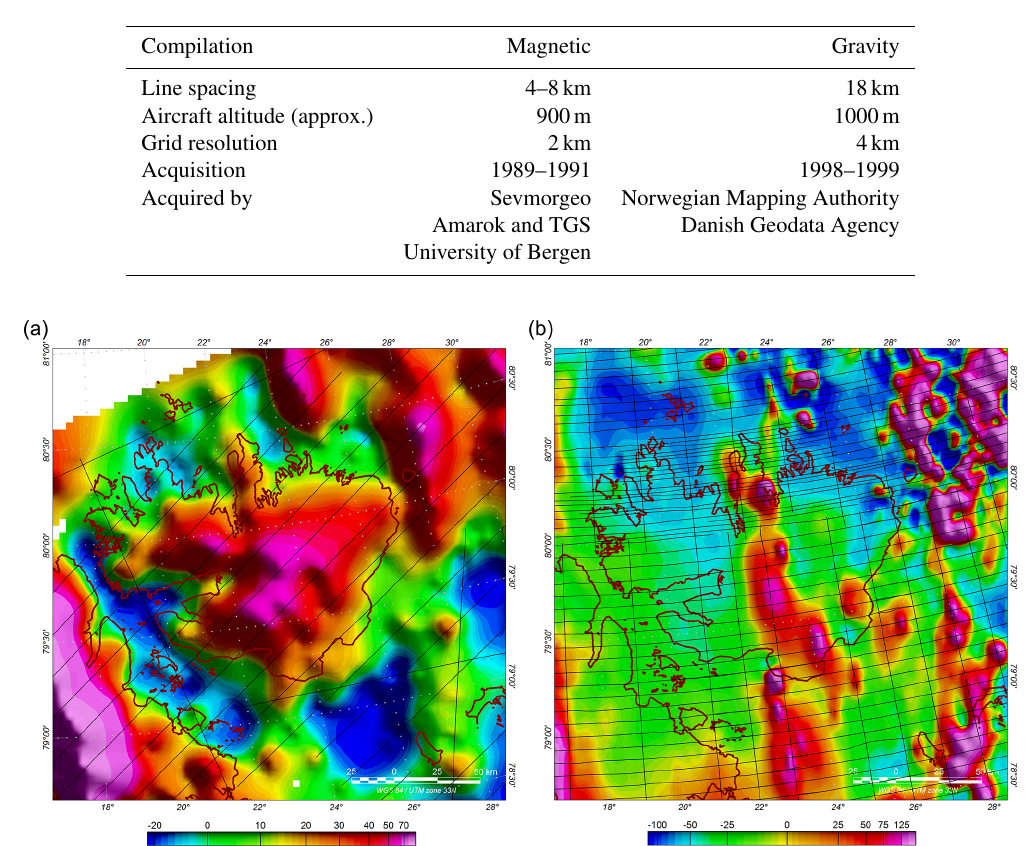
Table 1. Survey acquisition parameters of the magnetic and gravity compilation.